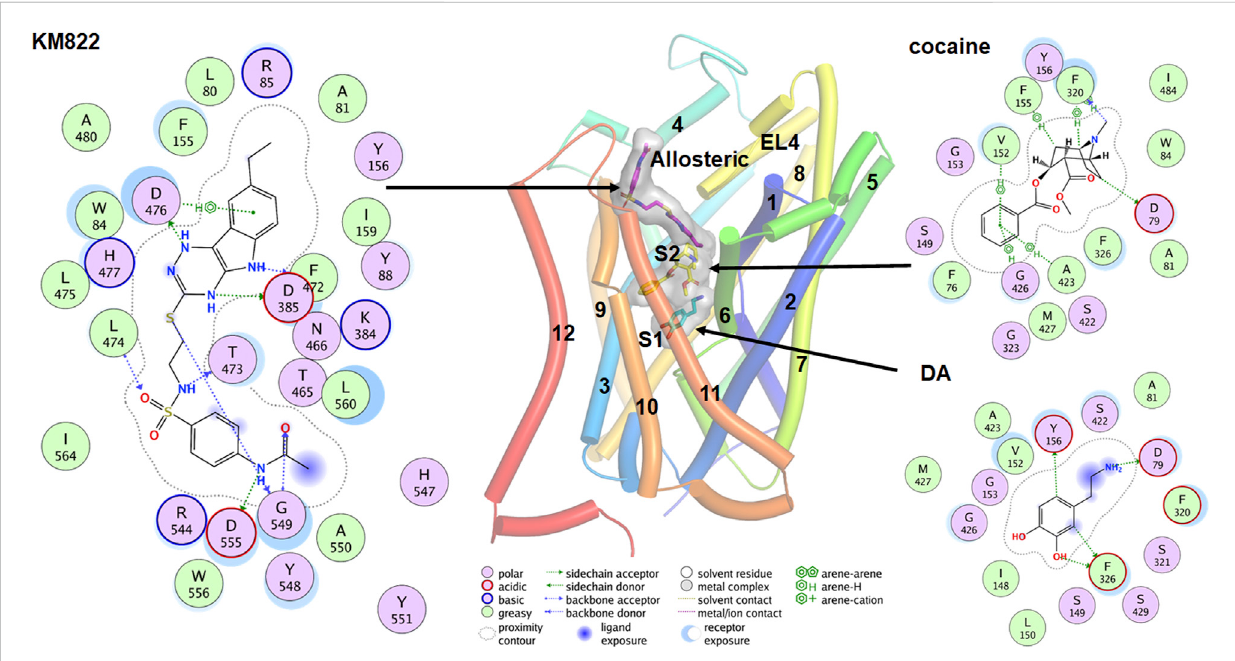
FIGURE 4 Binding poses for the DA, cocaine and KM822 molecules at the orthosteric (S1), S2, and allosteric site respectively. The ligand molecules are shown by the stick model with a transparent surface. The 2D ligand interactions map is also shown for the